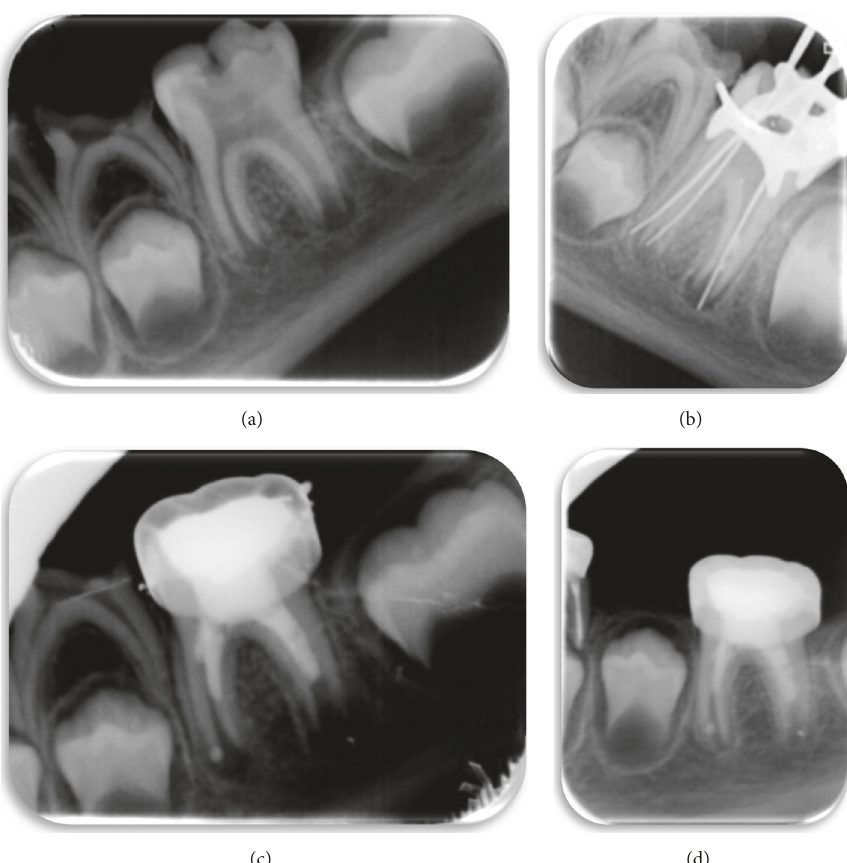
Figure 3: (a) Initial periapical radiograph: occlusal caries can be observed extending into the pulp chamber and radiotranslucency on the root apices. (b) A size 15K-file is used to irritate the apical tissue and stimulate bleeding. (c) Completion of revascularization. (d) Follow-up periapical radiograph, 8 months after completion of revascularization. The periapical radiotranslucency has disappeared and the walls of the root canal have thickened; apical closure has still not taken place. This should occur at the following